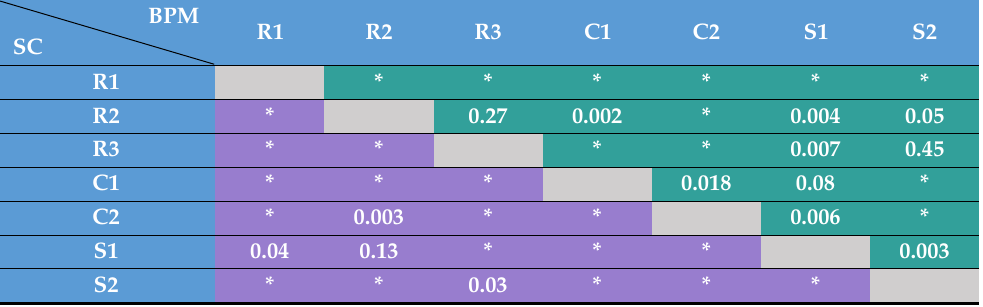
Table 3. The p -values of the Mann–Whitney U tests performed on the BPM and SC parameters that were measured during the resting (R1, R2, R3), the control (C1, C2) and the stress (S1, S2) periods of the experiment. Periods C1 and S1 correspond to the Stroop Color Word Task, while periods C2 and S2 correspond to the Mental Arithmetic Task. The values above the main diagonal correspond to the tests performed on BPM values, while the values below the main diagonal correspond to the tests performed on SC values. The asterisk symbol is placed where p -value is smaller than